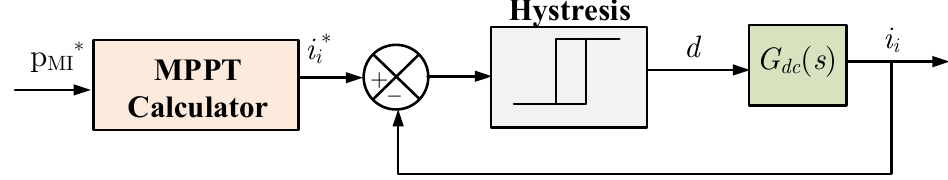
Figure 13. MI controller during DC/DC conversion to charge the battery.